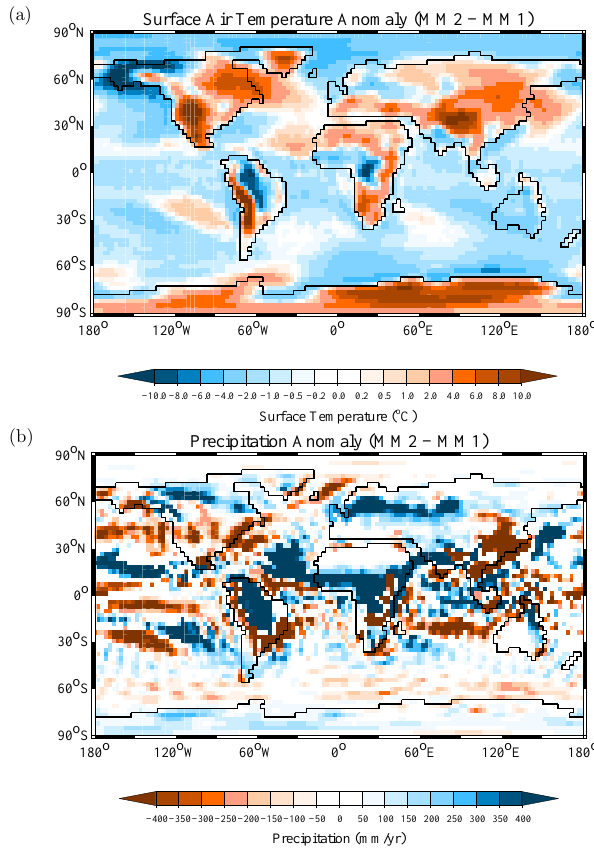
Fig. 8. Surface air temperature anomalies in (a) Northern Hemi- sphere summer (JJA) and (b) Northern Hemisphere winter (DJF) between experiments MM2 and